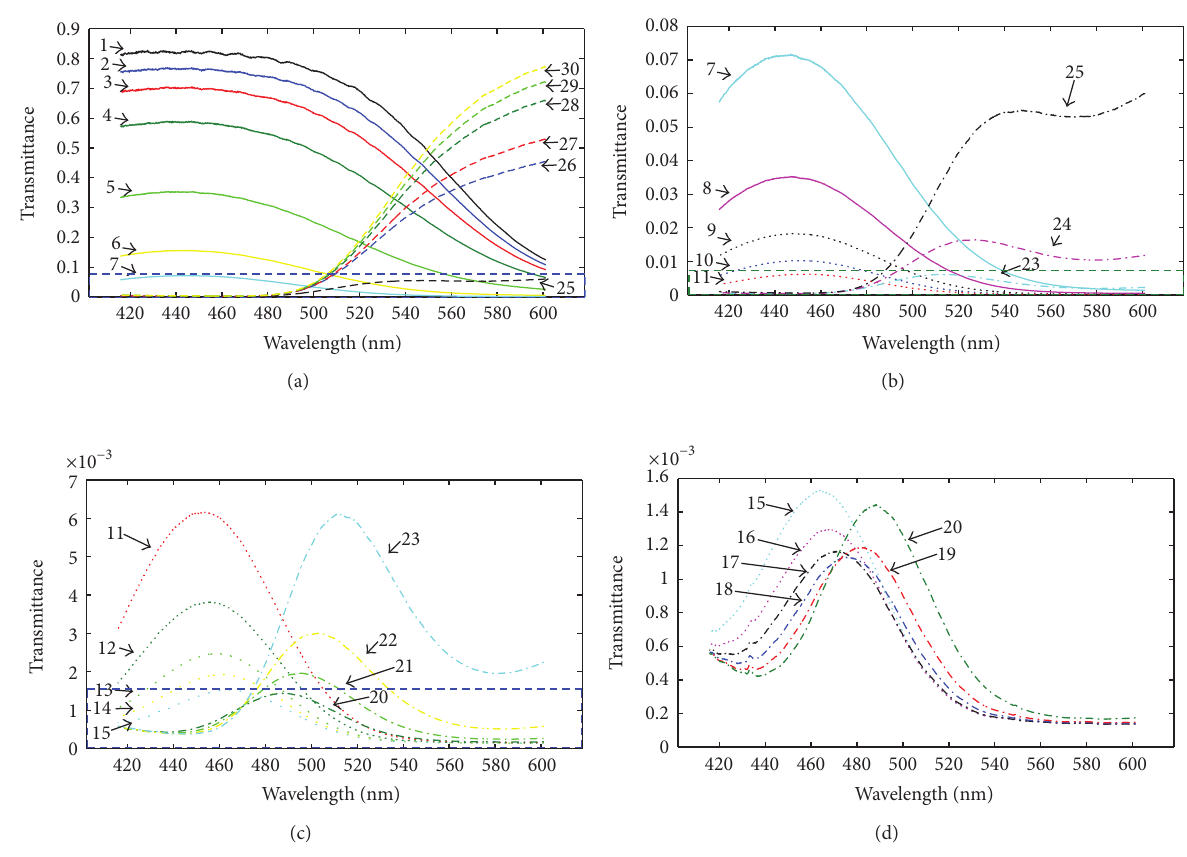
F 3: e normalized transmittance spectra of the 30 measurements for the positive electrolyte in Figure 2(a). e marked area in (a) is enlarged and shown in (b); the marked area in (b) is enlarged and shown in (c); the marked area in (c) is enlarged and shown in (d).